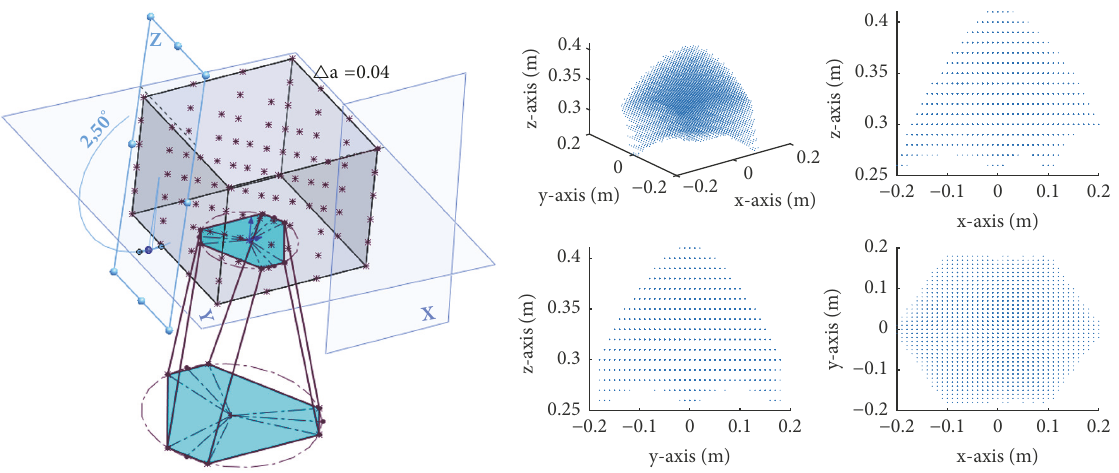
Figure 2: Volume representation of the workspace to be optimized for the SP and the overall